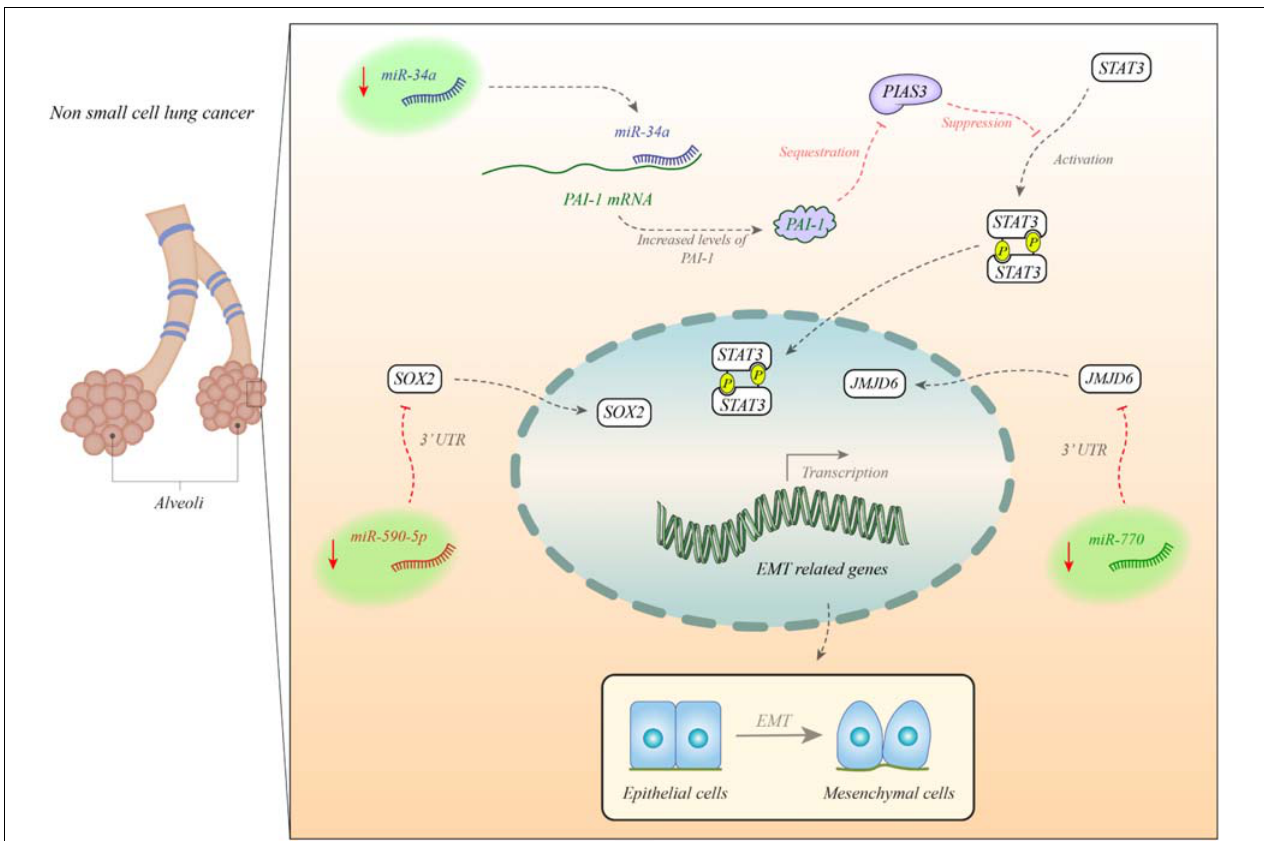
FIGURE 1 | miR-34a is decreased in non-small cell lung cancer (NSCLC). miR-34a blocks expression of PAI. PAI has a role in suppression of PIAS3 expression and blocking its effects on STAT3. STAT3 enhances expression of EMT-related genes (Wang D.X. et al., 2017). In addition, miR-770 and miR-590-5p are decreased in these patients. These miRNA suppress expression of JMJD6 and SOX2, respectively. Under-expression of these miRNAs leads to over-expression of EMT